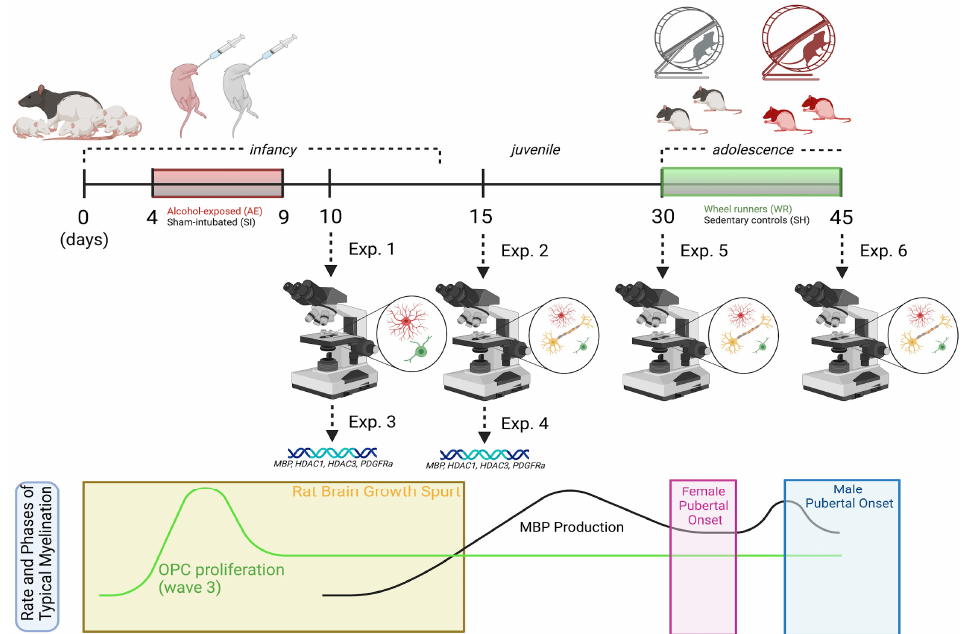
Figure 1. Experimental timeline with overlay illustrating the rate and phases of typical myelination in the rat brain from infancy to